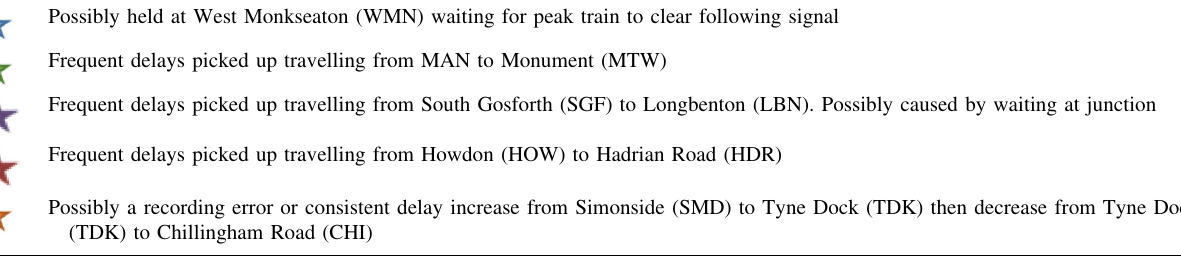
Table 3 Potential causes of the high average delays of Train 125 Possibly held at West Monkseaton (WMN) waiting for peak train to clear following signal Frequent delays picked up travelling from MAN to Monument (MTW) Frequent delays picked up travelling from South Gosforth (SGF) to Longbenton (LBN). Possibly caused by waiting at junction Frequent delays picked up travelling from Howdon (HOW) to Hadrian Road (HDR) Possibly a recording error or consistent delay increase from Simonside (SMD) to Tyne Dock (TDK) then decrease from Tyne Dock (TDK) to Chillingham Road (CHI)